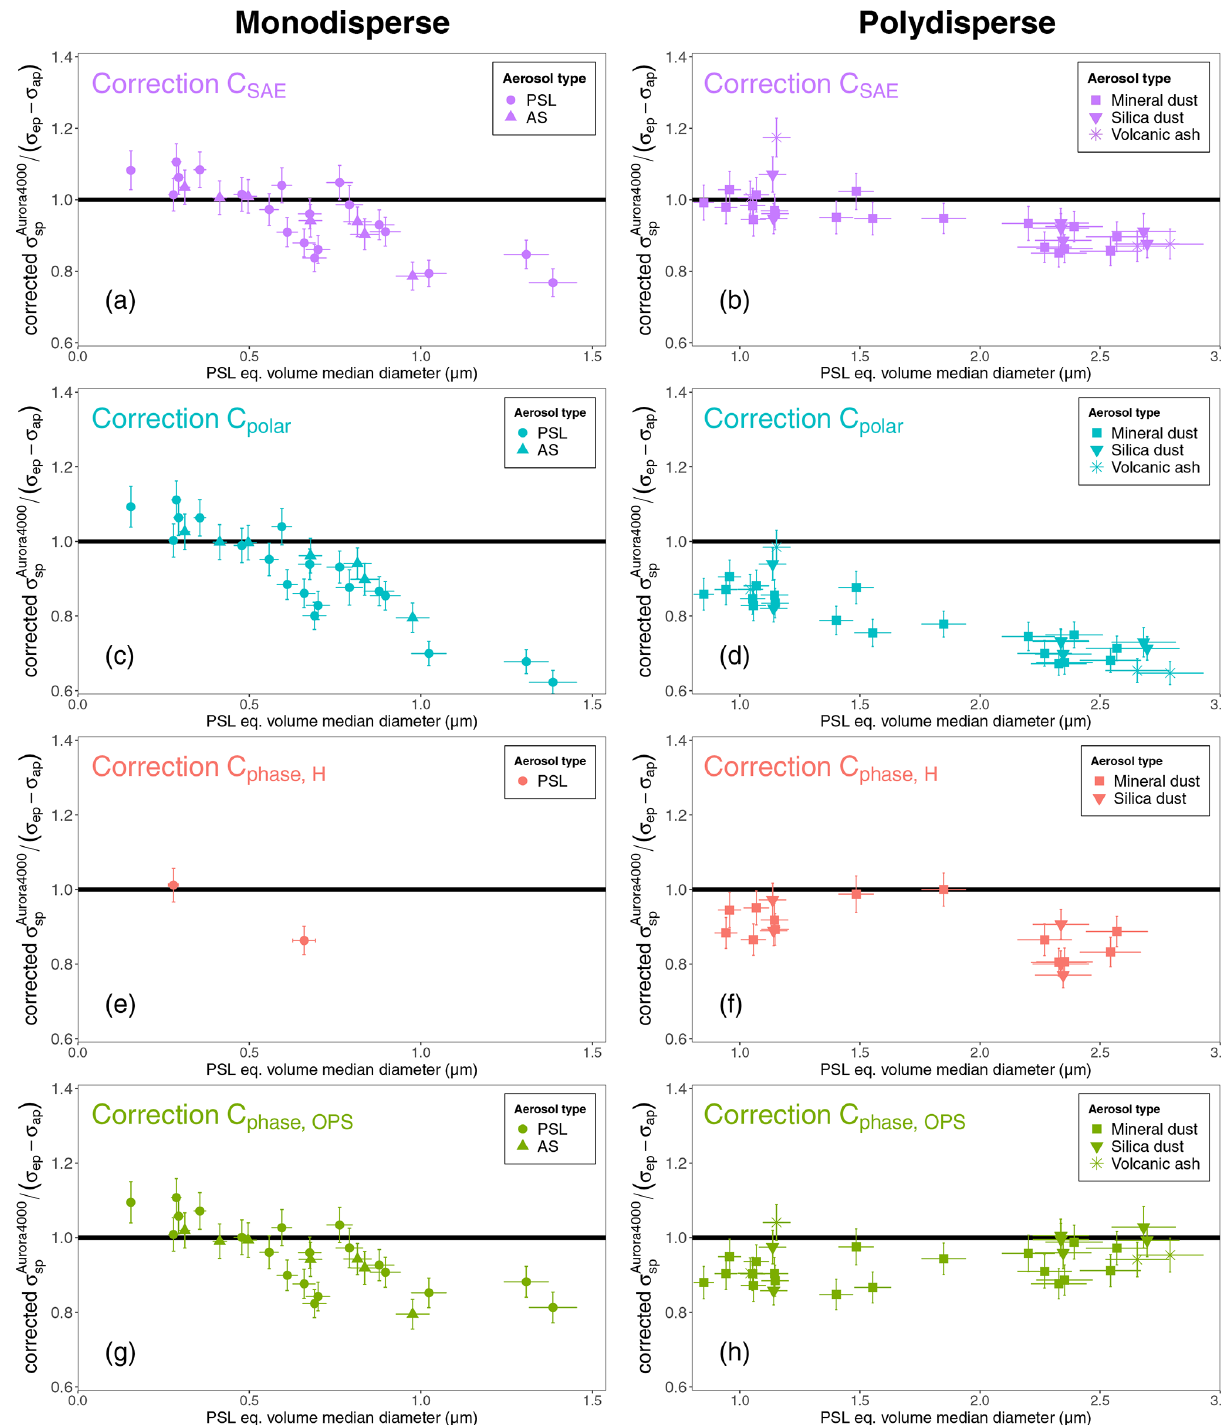
Figure 3. Result of the laboratory experiment for each angular correction. Ratio of the Aurora 4000 particle scattering coefficient corrected ◦ for angular truncation and illumination error (corrected σ Aurora4000 , 0 sp ) and the difference between the particle extinction coefficient and the particle absorption coefficient (σ ep − σ ap ) vs. the measured PSL equivalent volume median diameter. Each panel row shows the results for the ◦ σ Aurora4000 , 0 sp corrected with a different angular correction: (a, b) for the angular correction C SAE ; (c, d) for the angular correction C polar ; (e, f) for the angular correction C phase , H ; (g, h) for the angular correction C phase , OPS . Monodisperse aerosol measurements are reported in the panels on the left (a, c, e, g) ; polydisperse aerosol measurements are reported in the panels on the right (b, d, f, h) . Error bars represent the 95% confidence interval. Different symbols refer to different aerosol